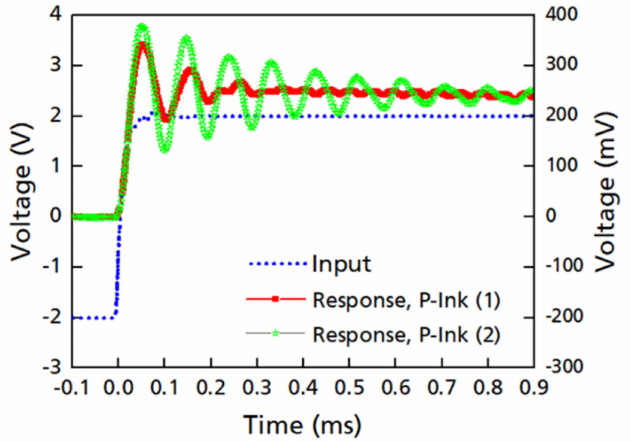
Figure 13. Waveform simulation (voltage vs. time) obtained from the Picoscope at 25 ◦ C for P-ink (1), and P-ink